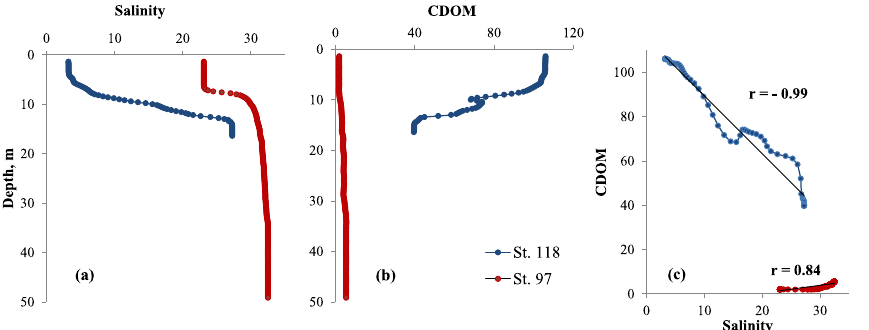
Figure 4. Depth profiles of salinity (a) and CDOM (QSU) (b) measured at two stations on the ESAS and (c) relationship between CDOM and salinity, September 2004; see Fig. 1 for location of stations.